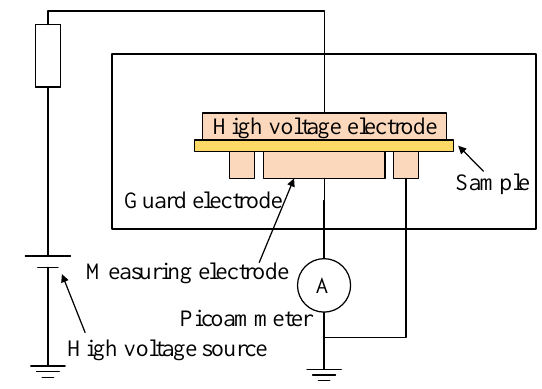
Figure 2. Schematic diagram of DC conductivity